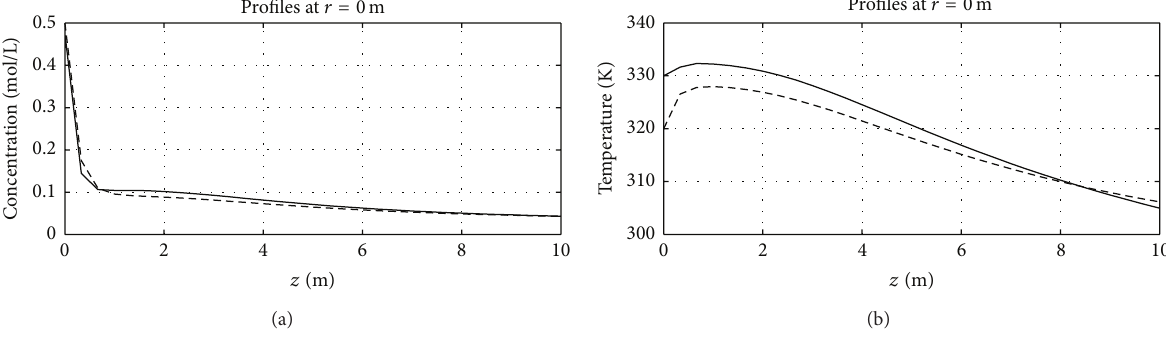
Figure 12: Steady state temperature and concentration profiles for Test 1 at 𝑟 = 0 m. Solid line—MPC. Dashed line—nominal profile